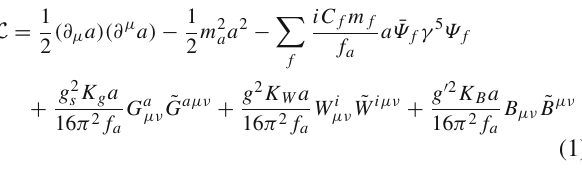
as for lighter fermions, whose mass arise from bilinear four-fermion interactions. f a / f ψ is an estimate of the ratio between the TCP decay constant f